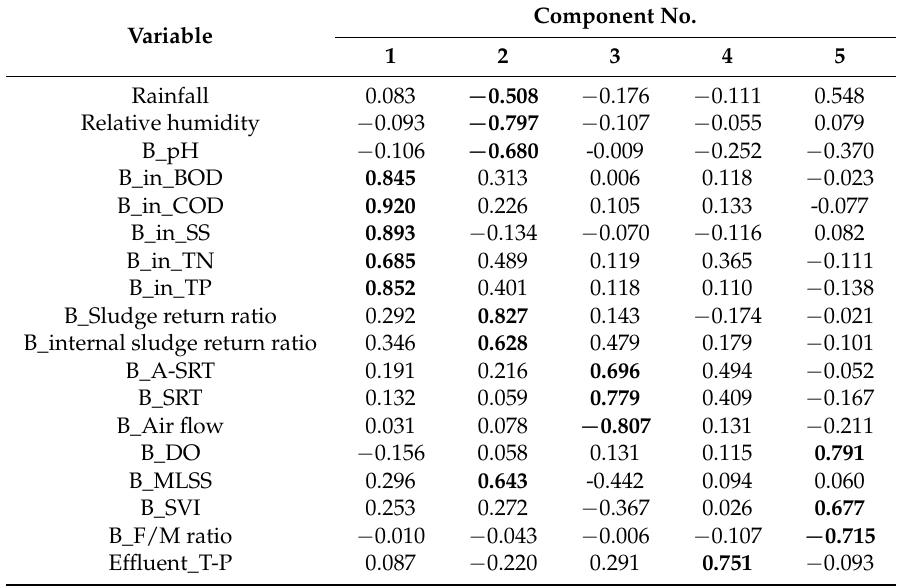
Table 8. Factor loadings for the variables related to effluent T–N concentration.